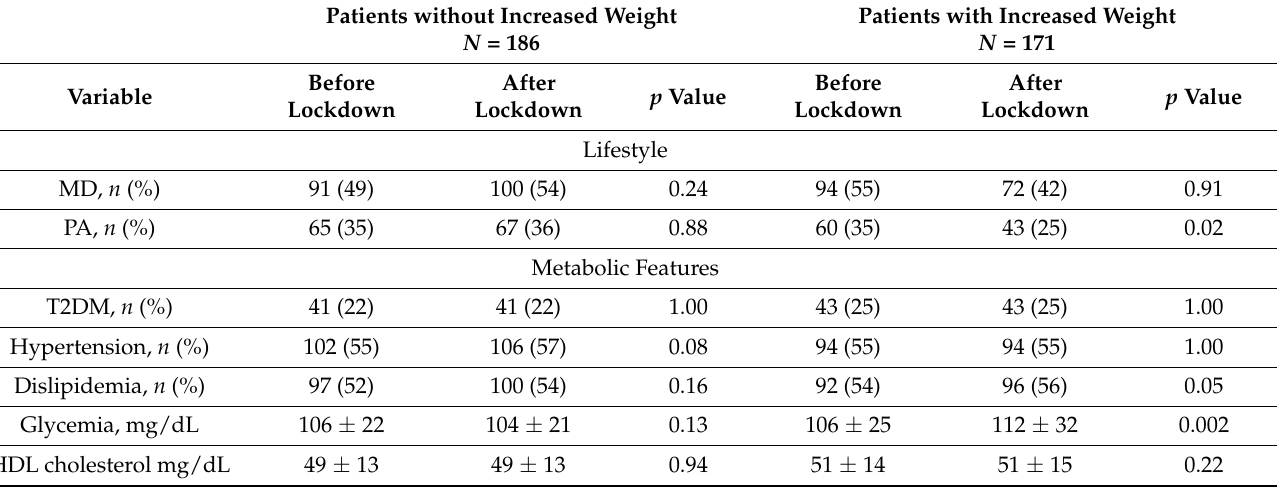
Table 3. Differences in metabolic and hepatic features after lockdown in the entire cohort according to weight